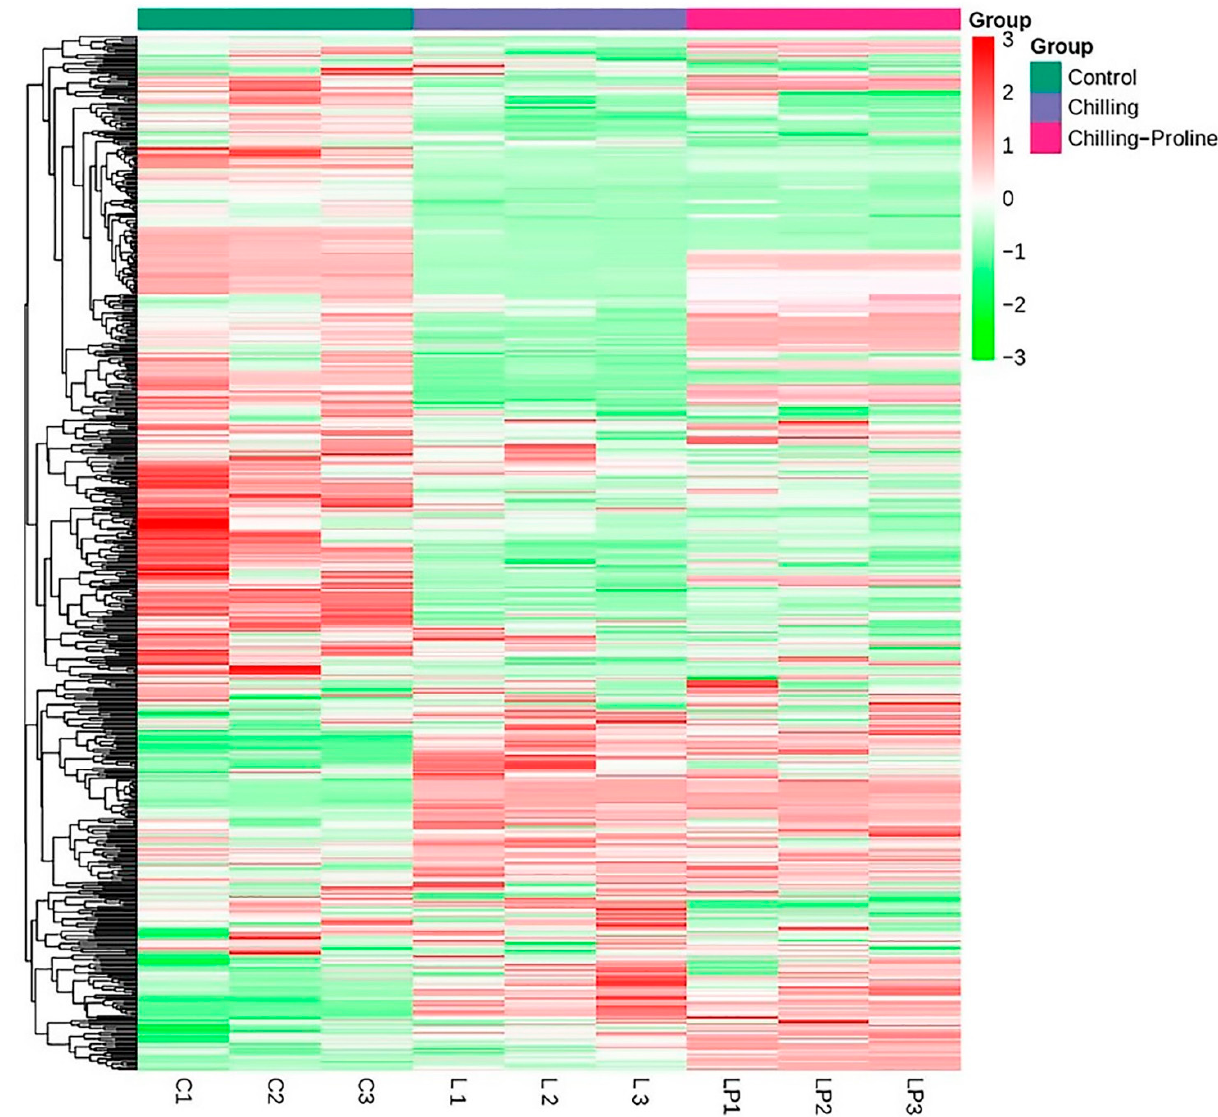
Figure 10. Heatmap and dendrogram of maize seed embryos under exogenous proline and low − temperature stress treatments.